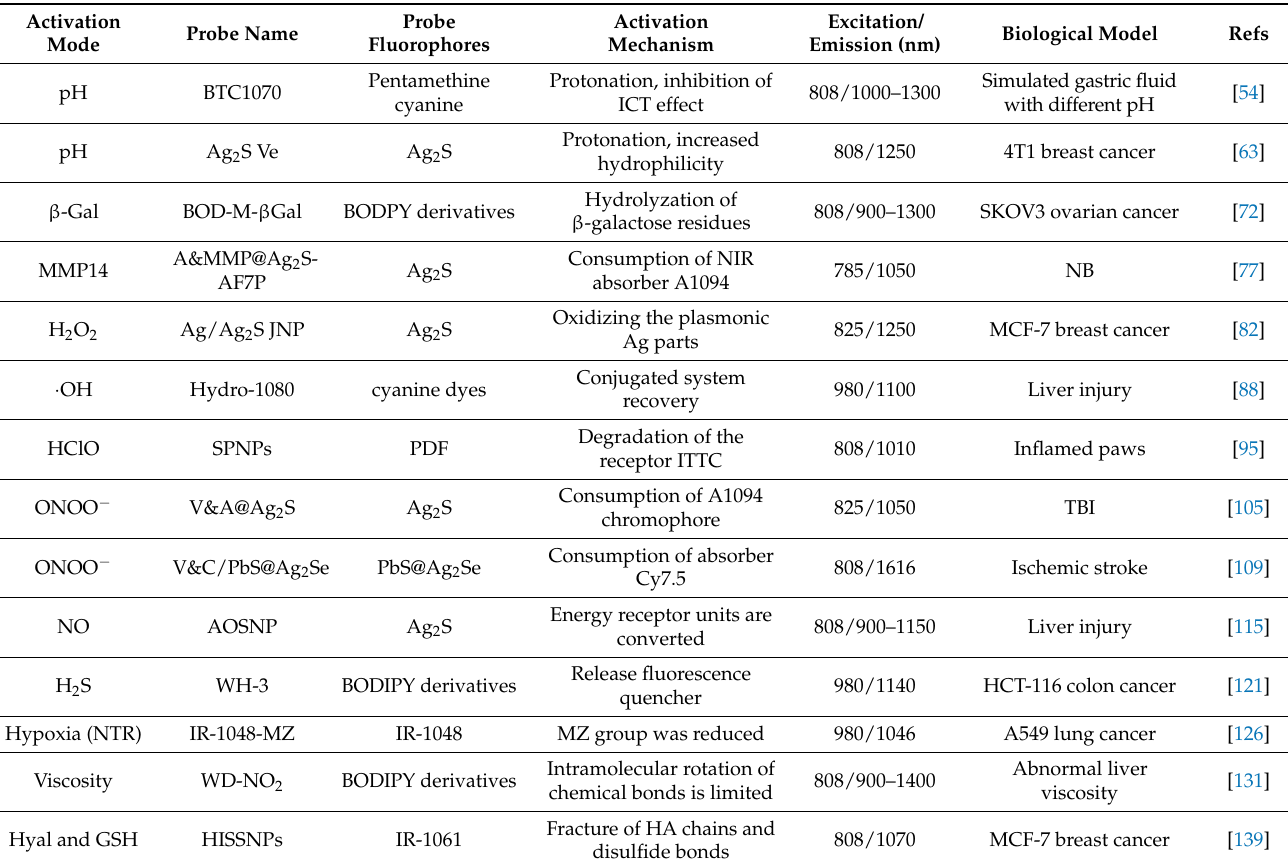
Table 1. Representatives of activatable NIR-II fluorescent probes for biomedical